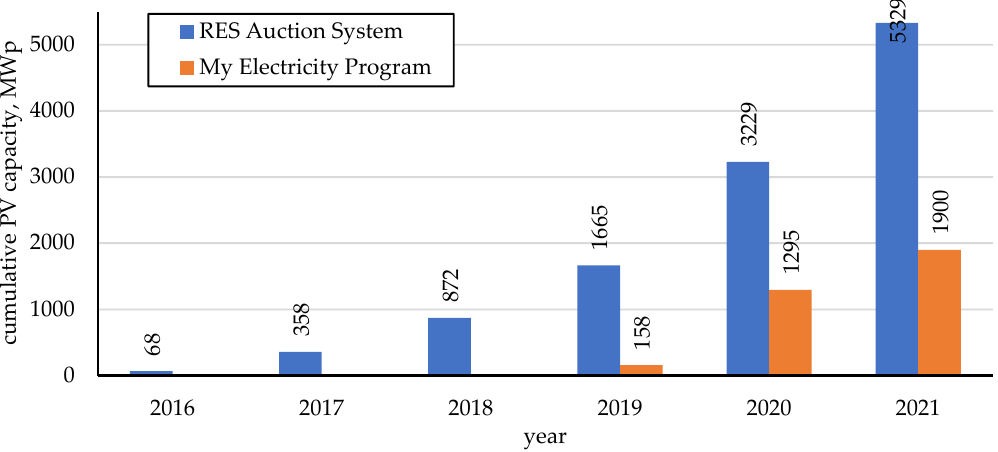
Figure 10. RES (PV) auction prices compared to the electricity price (TGE Base). Source: own study based on [38].